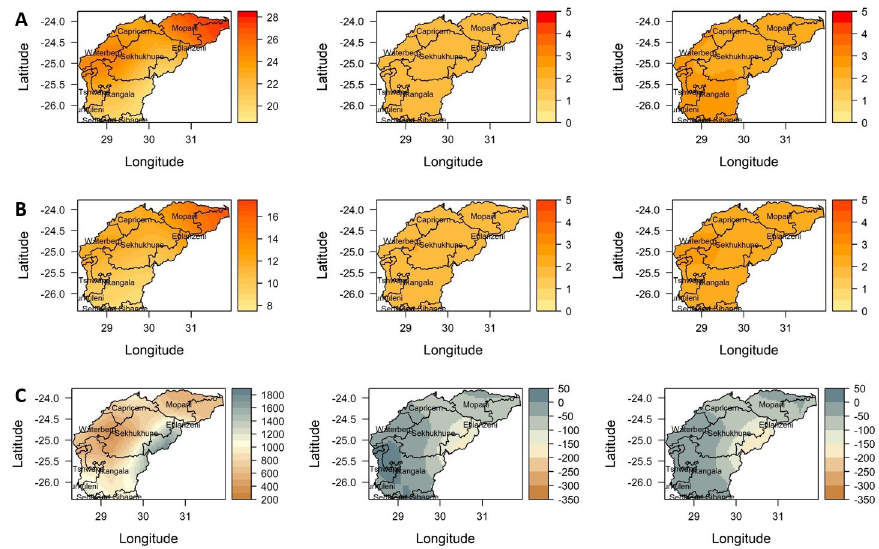
Fig 5. Projected changes in annual (A) mean maximum, (B) minimum temperature and (C) total rainfall, for 2036– 2065 (2nd column) and 2066–2095 (3rd column) periods under scenarios of the RCP4.5 relative to the baseline period 1976–2005 (1st column) over the Olifants River Catchment. "Basemap (Water management shapefile was collected from the South Africa National Department of Water and Sanitation on http://www.dwa.gov.za/iwqs/gis_data/" [29].